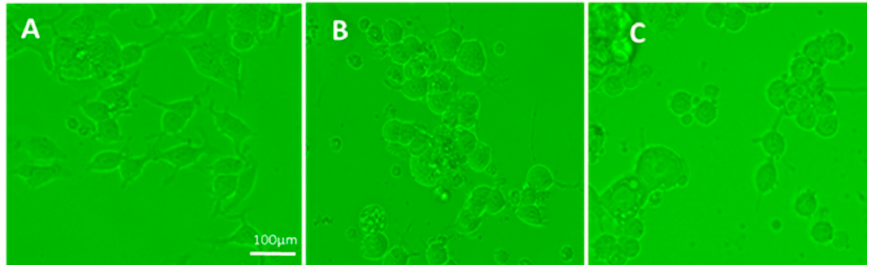
Figure 1. ( A ) Control N2A cells: cells spread and formed processes as early as two days in culture in the presence of medium only; ( B ) N2A cells two days after exposure to influenza vaccine; ( C ) N2A cells two days after exposure to S. Typhi vaccine. In both B and C, cells were mostly rounded and deprived of processes (either could not form and / or retracted processes), compared to cells cultured in the presence of medium.